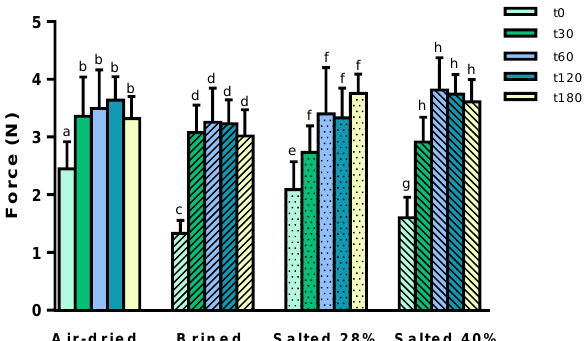
Figure 2. Force (N) required to fracture Ulva rigida submitted to di ff erent preservative processes (air-drying, brining, salting at 28% and 40%), over six months of storage; t0, t30, t60, t120, t180 correspond to day 0 (i.e., just after the application of the processing treatment), and after storage for 30, 60, 120, and 180 days, respectively. Storage was done at room temperature (air-dried) or at 4 ◦ C (salt-processed). The results correspond to mean ± standard deviation (n > 5). Di ff erent letters in a treatment condition indicate significant di ff erences ( p < 0.05) according to Tukey´s test.